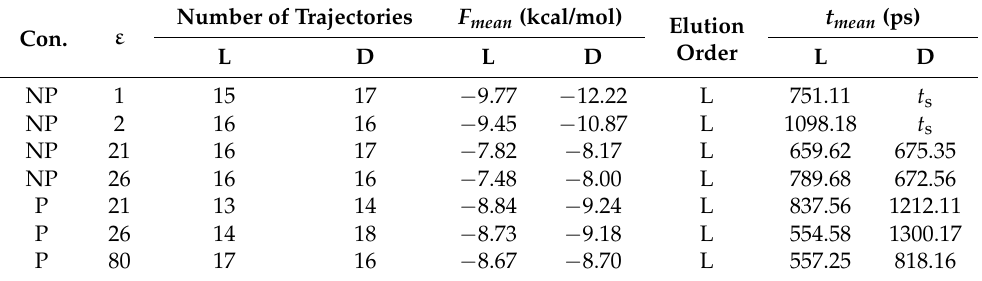
Table 2. The number of trajectories, average binding free energy F mean , elution order and the average residence time t mean obtained for each enantiomer in the molecular dynamics simulation. t s is the simulation time (5